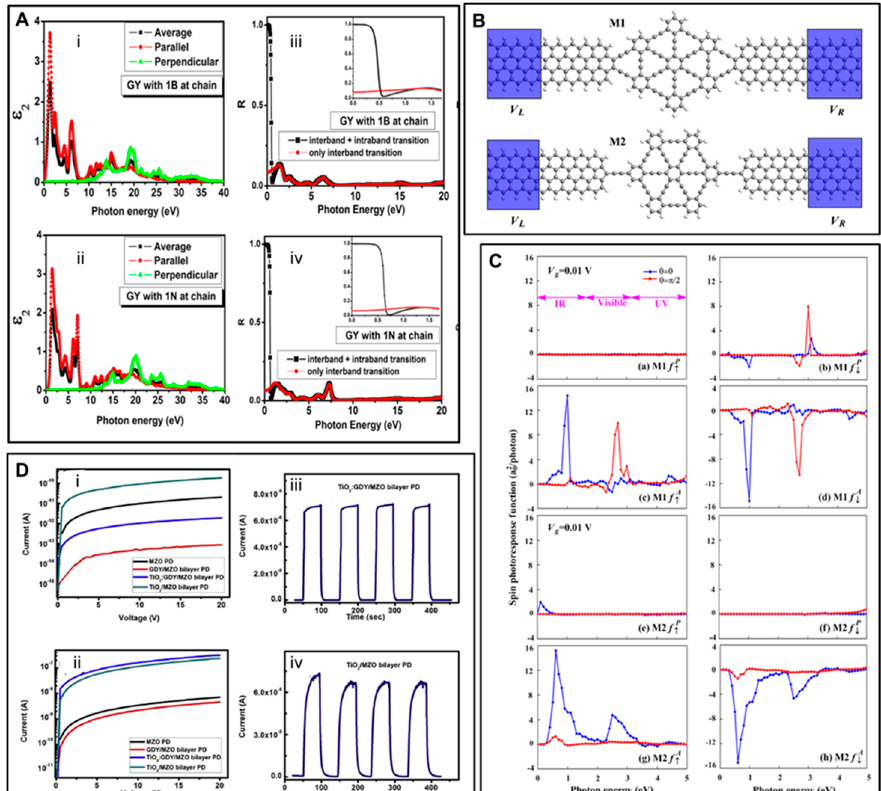
Figure 18. The 1B ( Ai ) and 1N ( Aii ) doped GYs’ relationships between the imaginary part of the dielectric function and photon energies taken for different directions of electric fields. The reflectivities of inter- and intraband transitions found for 1B ( Aiii ) and 1N ( Aiv ) doped GYs. Reproduced with permission [154]. Copyright 2016, American Chemical Society. Scheme of the designed devices ( B ). The parallel and antiparallel spin-polarized photoresponse of M1 ( Ca–d ) and M2 ( Ce-h ) devices. Reproduced with permission [155]. Copyright 2017, IOP Publishing Ltd. I–V sweeps of the considered photodetectors working without ( Di ) and ( Dii ) with UV light (254 nm) irradiation. The on/off features of the TiO2:GDY/MZO bilayer PD ( Diii ) and the TiO2/MZO bilayer PD ( Div ). Reproduced with permission [157]. Copyright 2020, Elsevier.